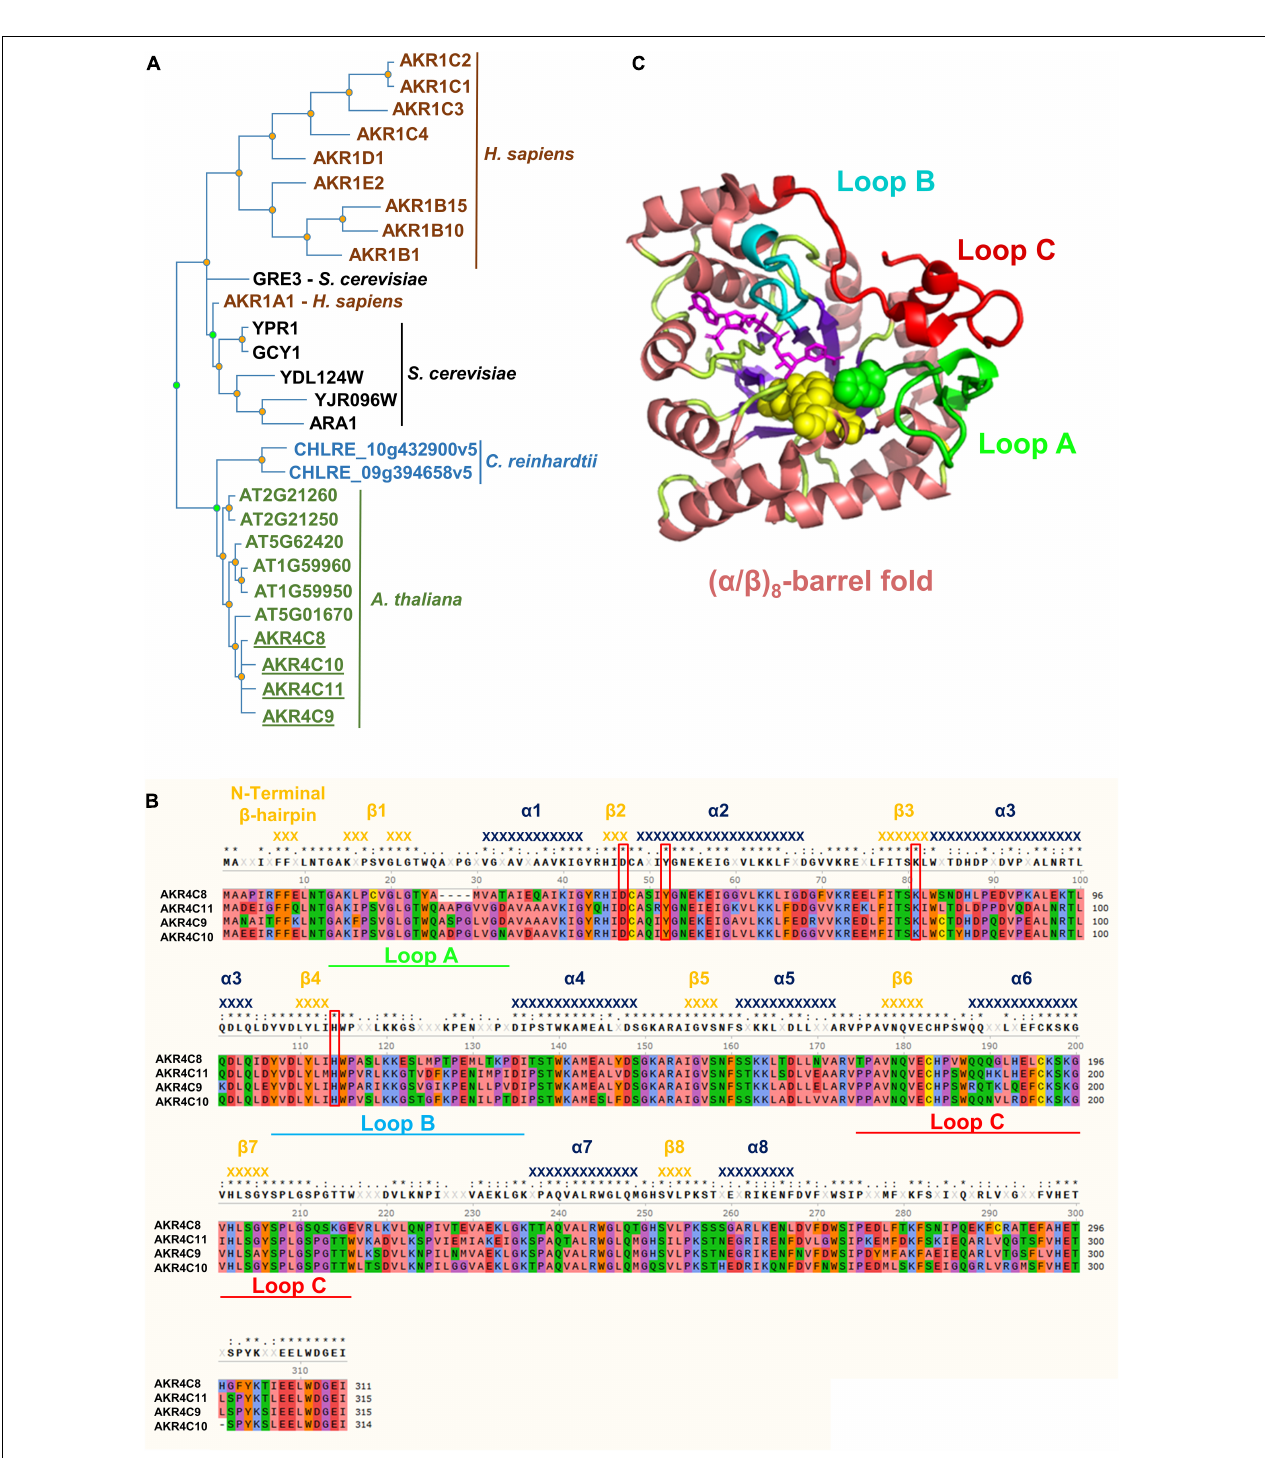
FIGURE 3 | Phylogenetic tree, structure, and amino acid alignment of A. thaliana AKR4C proteins. (A) Phylogenetic tree of AKRs was constructed by searching for aldo-keto reductases (PTHR11732) in the Panther database using the online tool PhyloGenes. Organisms included were Chlamydomonas reinhardtii , Saccharomyces cerevisiae , Homo sapiens , and A. thaliana . UniProt identifier: AKR1C2, P52895; AKR1C1, Q04828; AKR1C3, P42330; AKR1C4, P17516; AKR1D1, P51857; AKR1E2, Q96JD6; AKR1B15, C9JRZ8; AKR1B10, O60218; AKR1B1, P15121; GRE3, P38715; AKR1A1, P14550; YPR1, Q12458; GCY1, P14065; YDL124W, Q07551; YJR096W, P47137; ARA1, P38115; CHLRE_10g432900v5, A0A2K3D9Z5; CHLRE_09g394658v5, A0A2K3DEH4; AT2G21260, Q9SJV1; AT2G21250, Q9SJV2; AT5G62420, Q9FJK0; AT1G59960, Q9SXC0; AT1G59950, Q1PFI5; AT5G01670, F4K9G7; AKR4C8, O80944; AKR4C10,